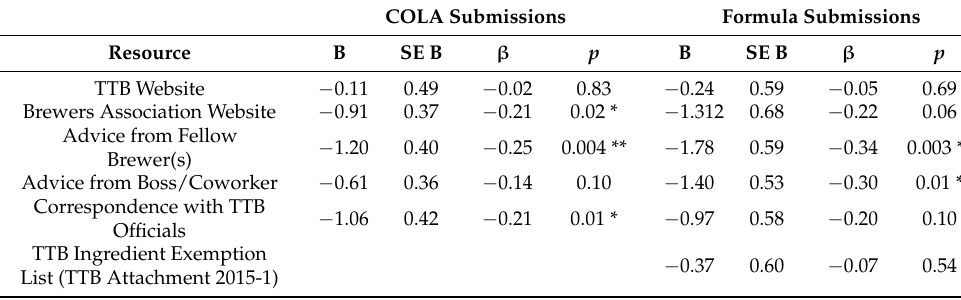
Table 16. Prediction of Information Burden Using Resource